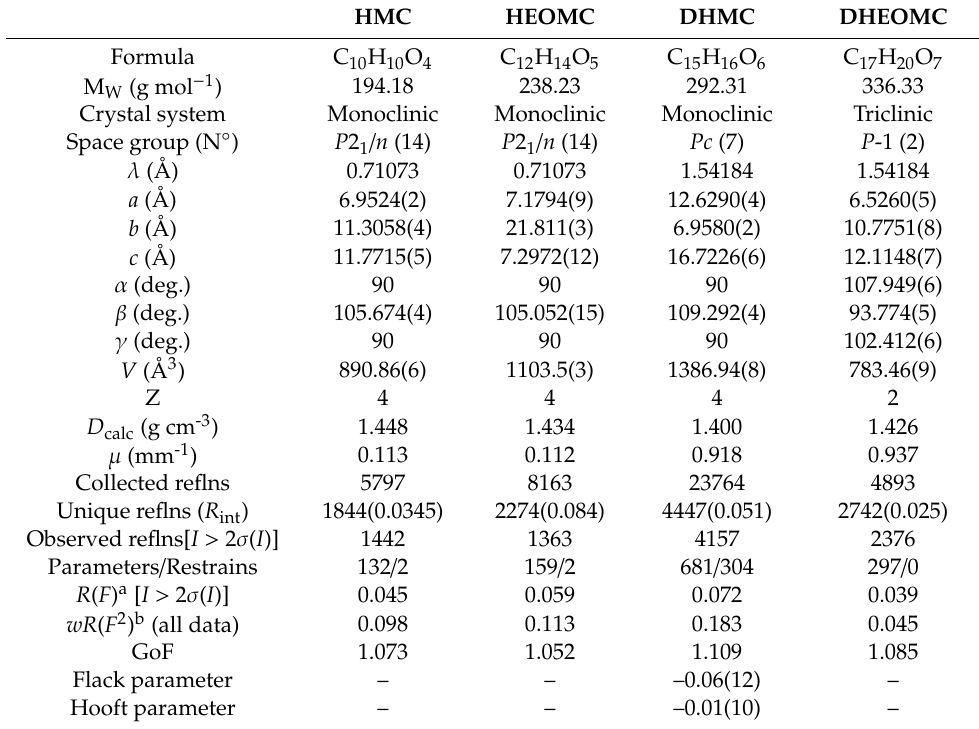
Table 2. Crystallographic data for HMC, HEOMC, DHMC and